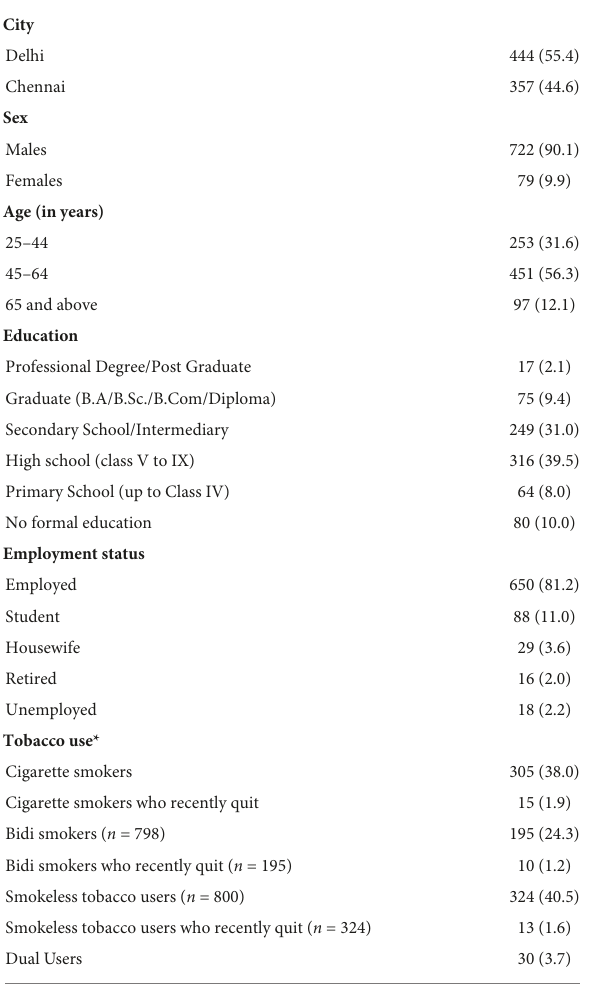
TABLE 1 Socio-demographic characteristics of the study participants ( n =